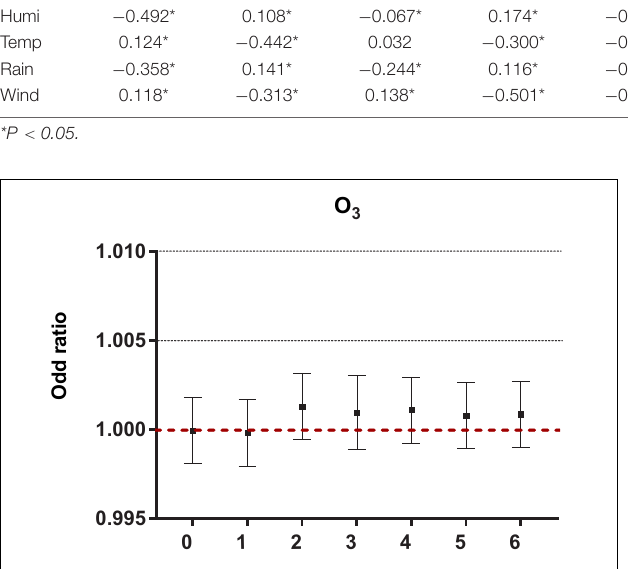
FIGURE 1 | The correlation of ozone in different lag periods to acute asthma attacks in the single pollutant model.